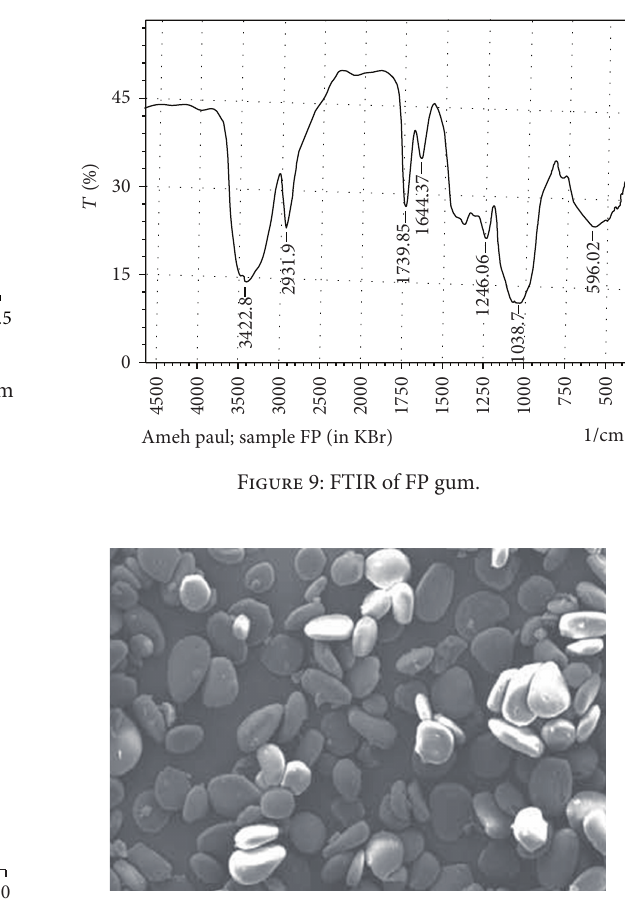
F 10: Scanning electron micrograph of Ficus platyphylla with sp log(𝜂𝜂 ) log([𝜂𝜂𝜂𝜂